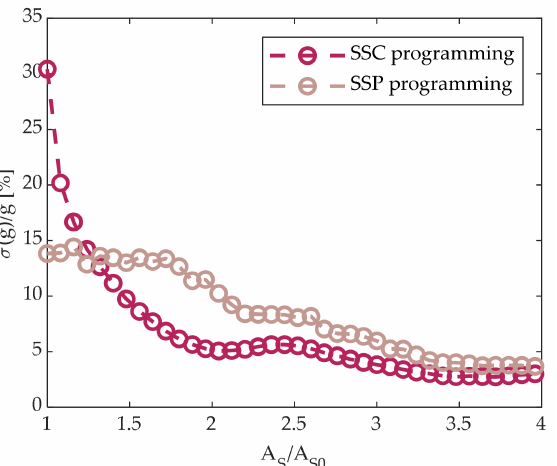
Figure 12. Normalized standard deviation σ (g)/g defined in (5) as a function of SET pulse amplitude for both SSP and SSC